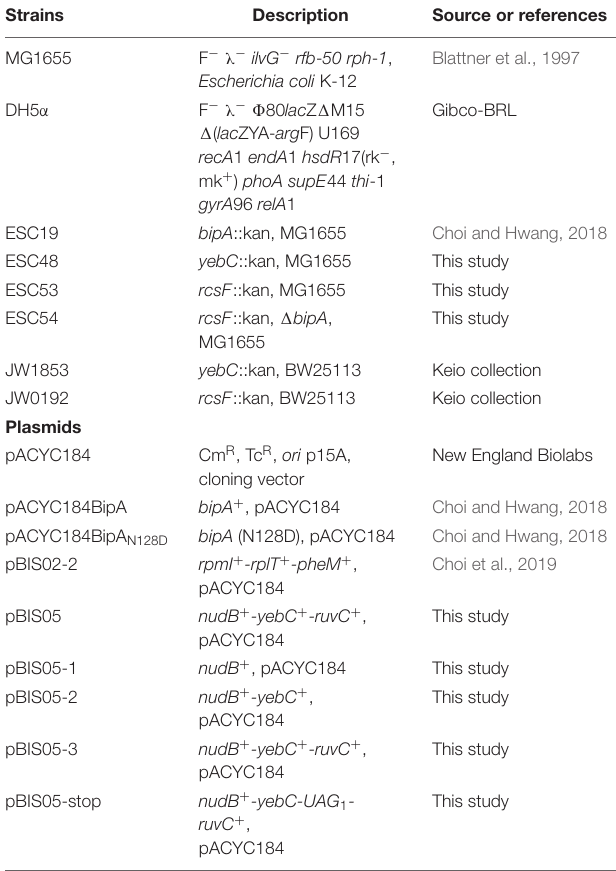
TABLE 1 | Strains and plasmids used in this